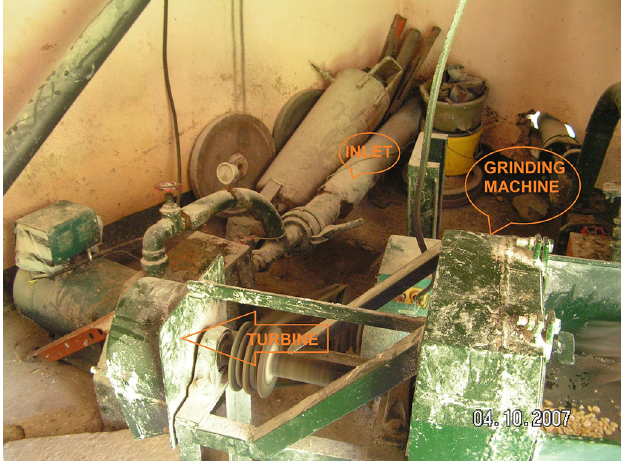
Fig. 5. Locally made micro pelton connected to a grinding machine at Batocha Cameroon (Photo J.